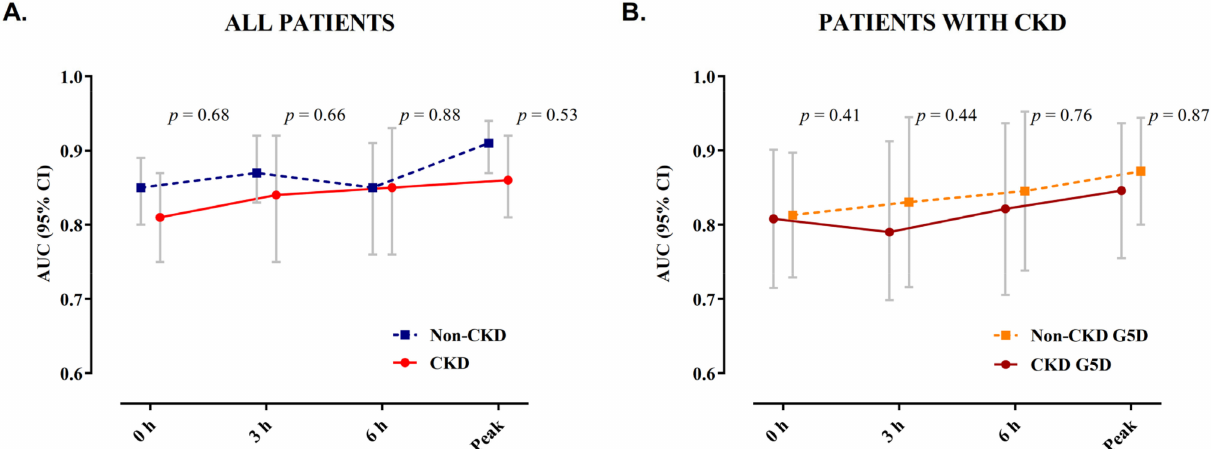
Figure 4. AUC of hs-cTnT during serial sampling. Depicted are the AUCs with 95% confidence intervals for hs-cTnT during serial sampling at presentation, 3 h, 6 h, and peak prior to coronary angiography in ( A ) patients with normal renal function and those with severe CKD and ( B ) among patients with severe CKD, comparing patients with CKD G5D to those with severe CKD but preserved diuresis. AUC, area under the receiver operating characteristic curve; CKD, chronic kidney disease; CKD G5D, chronic kidney disease G5 treated by dialysis.